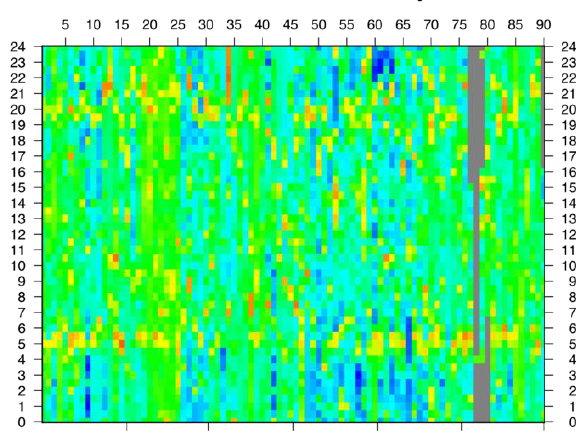
Figure 15. Heat maps that show the distribution of SPL for the 125 Hz one-third octave band as a function of the hour of the day versus day during the period 21 November 2020 and 13 February 2021. It is easy to recognize that in the morning (between 5 a.m. and 6 a.m.) there are high SPL values, probably due to the presence of fishing boats. Higher values can be found also between 7 p.m. and 10 p.m., but they are more spread in time.